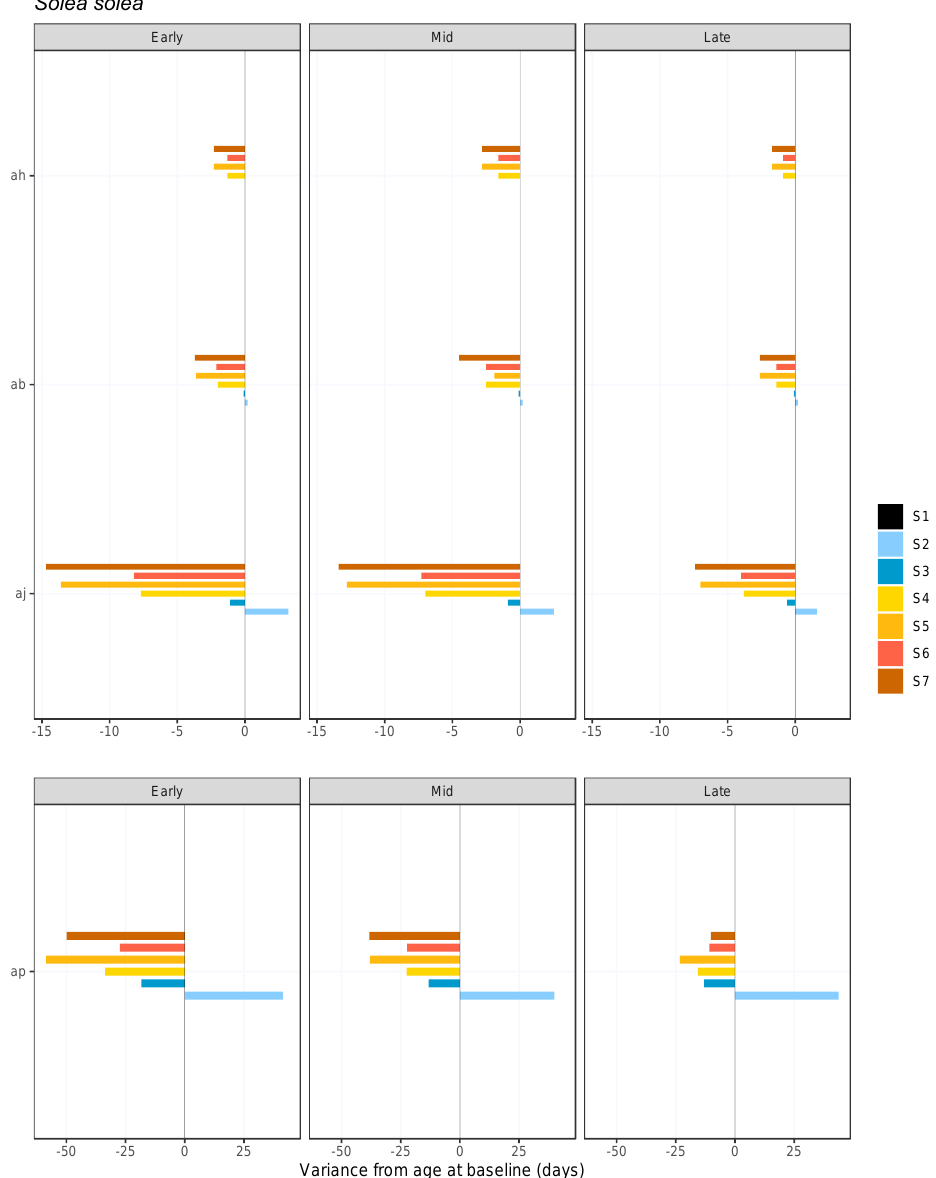
Figure 3. Time variance from baseline (S1, black line in figure) for age at hatching (ah), birth (ab, start of exogenous feeding), end of metamorphosis (aj), and puberty (ap) in S. solea individuals issued from early, mid and late spawning events and growing under the seven different scenarios (please see Table 1 for scenario descriptions).